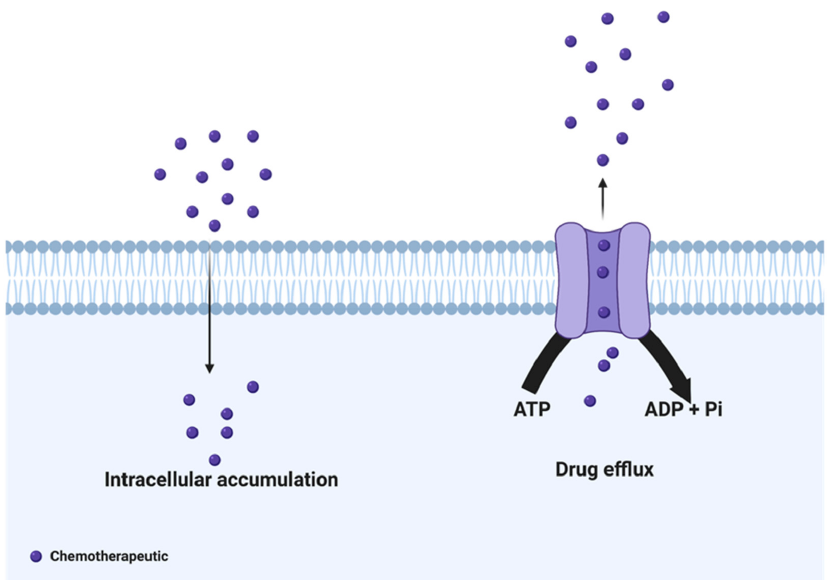
Figure 1. Generic scheme of drug efflux proteins. The adenosine triphosphate (ATP) Binding Cassette (ABC) family of membrane proteins enables the efflux of therapeutics. ABC transporters (light purple) use ATP to pump chemotherapeutics (dark purple) out of the cell.